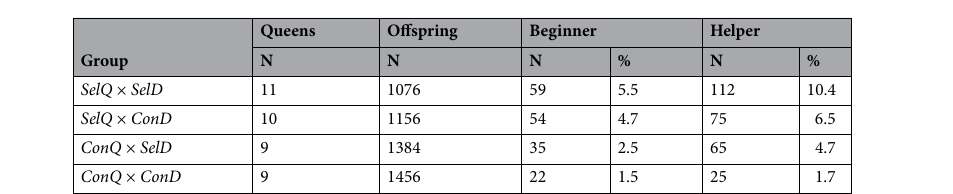
Table 2. Grouping considering genetic origin of queens and drones. Summary of the number (N) of inseminated queens per group and their offspring (worker bees). Displayed are furthermore the number of beginner and helper bees in each group (N) and the corresponding equivalent in percent per group (%).